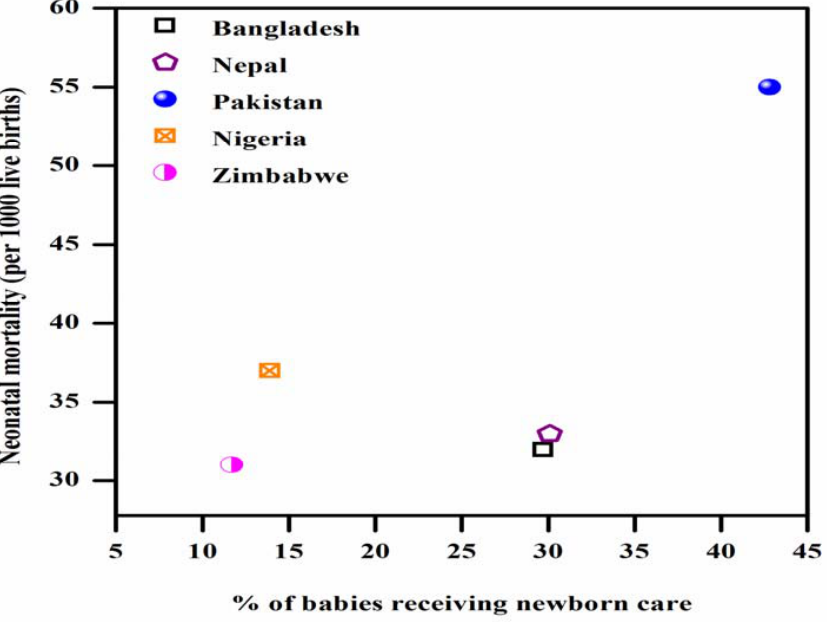
Figure 6. Relationship between neonatal mortality and postnatal care within the first 48 h of life.